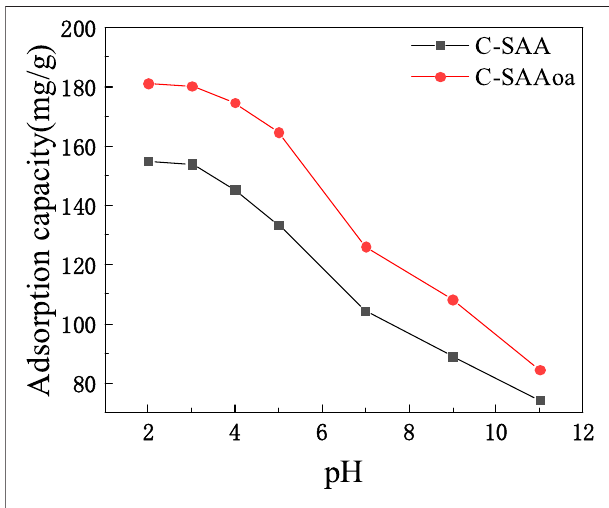
FIGURE 6 | Effect of pH on fl uoride removal by C-SAA and C-SAA oa .